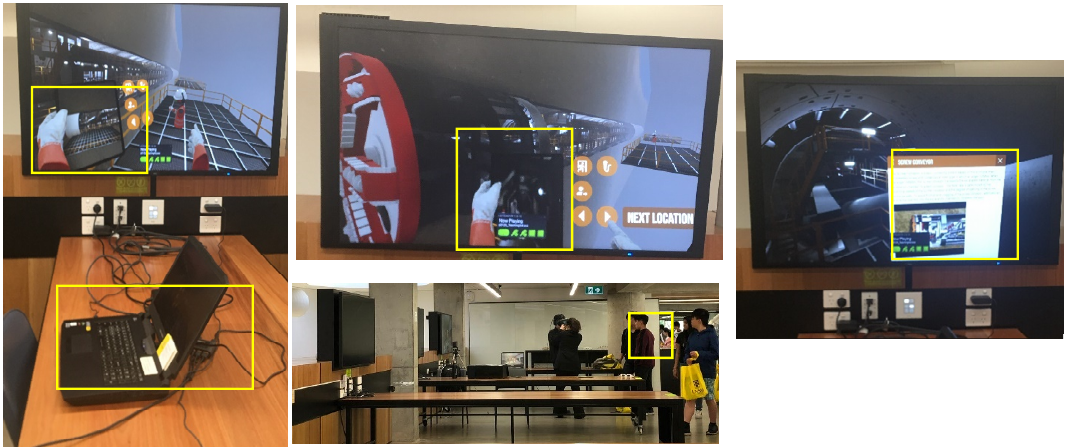
Figure 12. Screenshots from the menu and different sections.